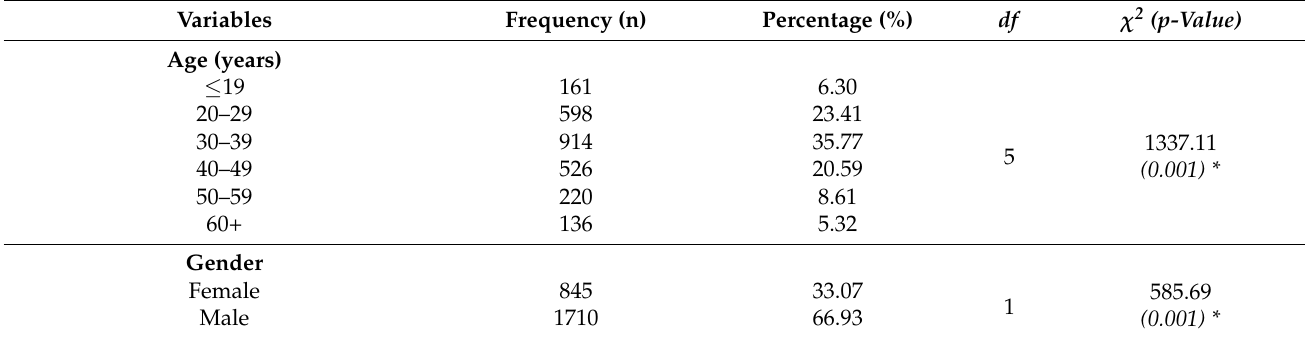
Table 1. DR-TB patients characteristics in Nigeria (2010–2016) ( n = 2555